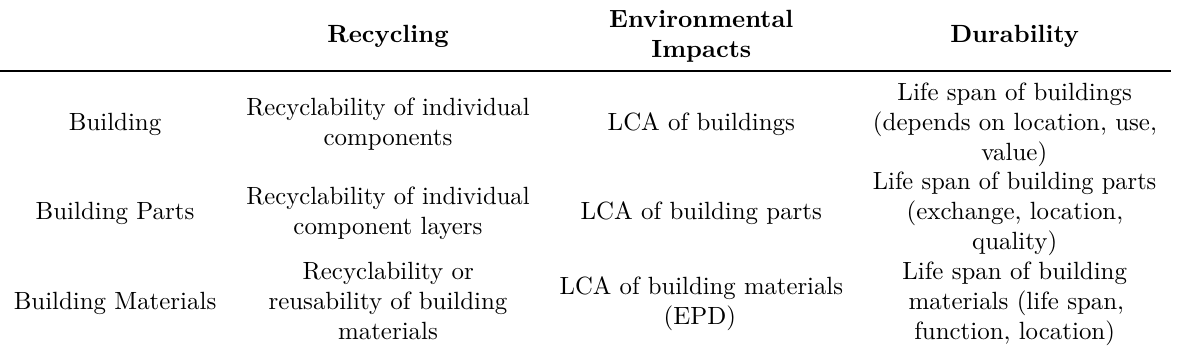
Table 1. Considerations of sustainable use of resources